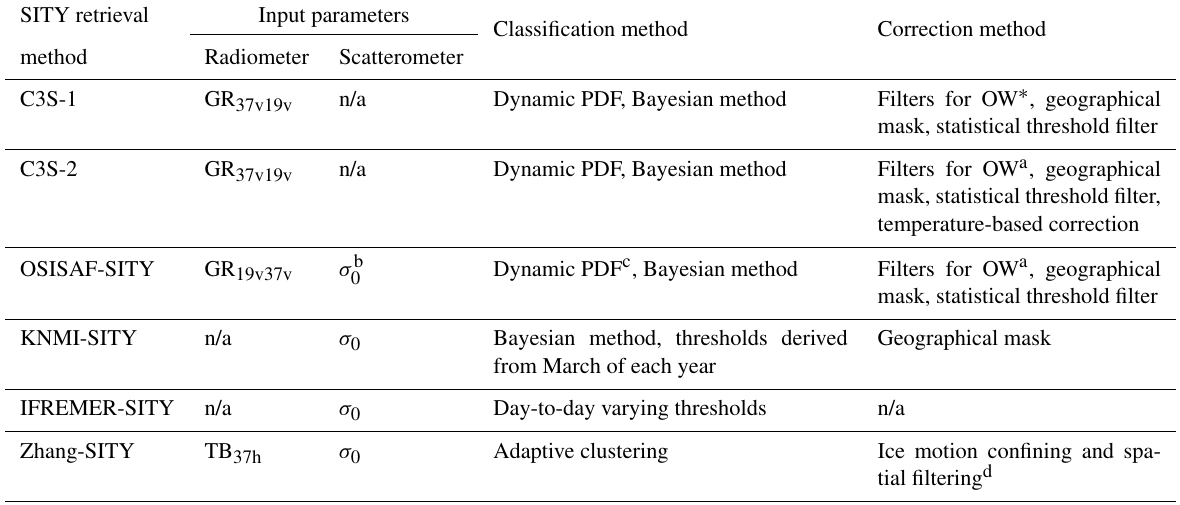
Table 2. SITY retrieval methods. SITY